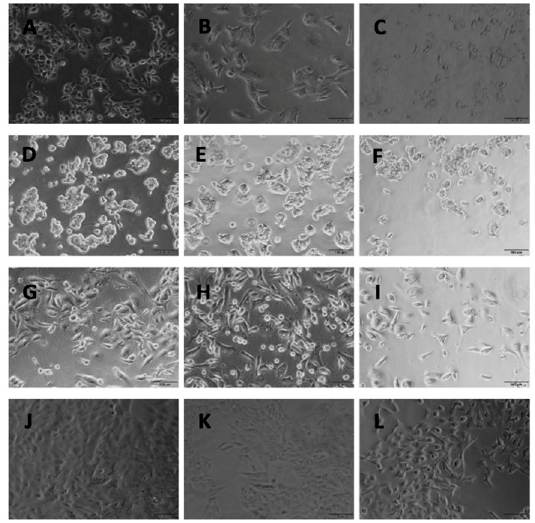
Figure 1. Incubation of Ru 1 ( A , D , G , J ), Ru 2 ( B , E , H , K ), Ru 3 ( C , F , I , L ) compounds for 48 h on DU145 ( A –